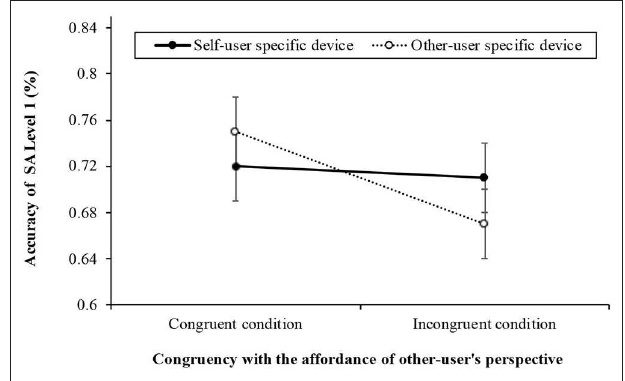
FIGURE 4 | The results of accuracy ( ± SE ) for answering the situation awareness (SA) Level 1 as the congruency with between the affordance of the other user’s perspective and the word (2: congruent, incongruent) and the primary user-specific devices (2: self, other) in Experiment